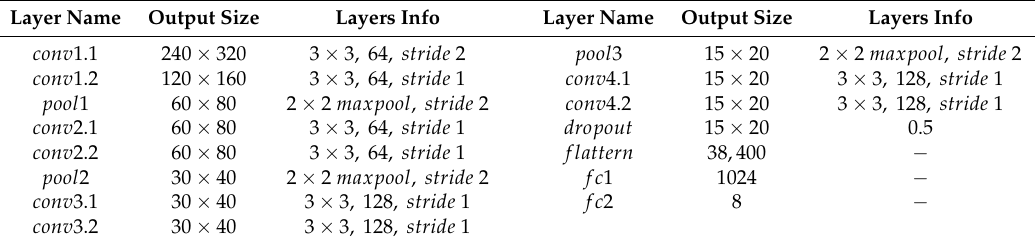
Table 2. The details of the architecture of the regression